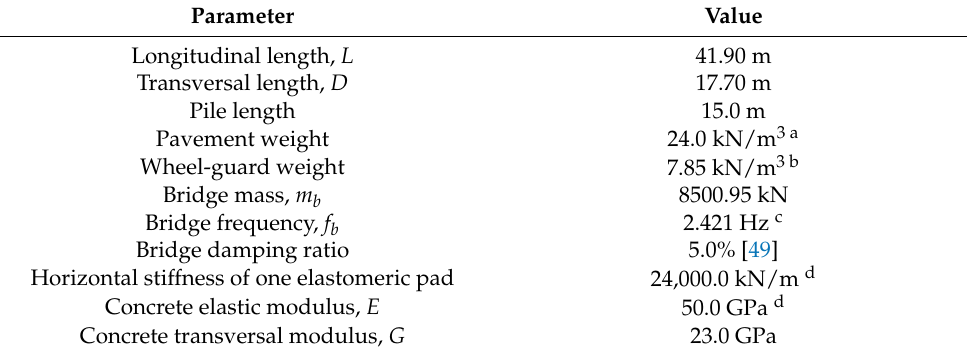
Table 1. Bridge Table 1. Bridge data.